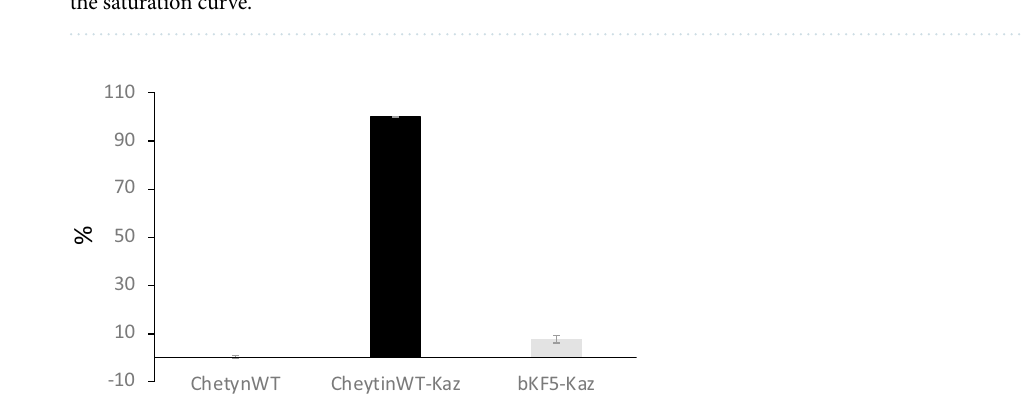
Figure 7. Interactions of the bKF5 with the Kazα target assess by ITC. In Grey: Isothermal calorimetric titrations of Kazα (25 μM) with the bKF5 binder (220 μM). In Black: calorimetric titrations of Kazα (25 μM) with CheytinWT (220 μM). Parameters of the binding reaction, K D and stoichiometry (n) are extrapolated from the saturation curve.